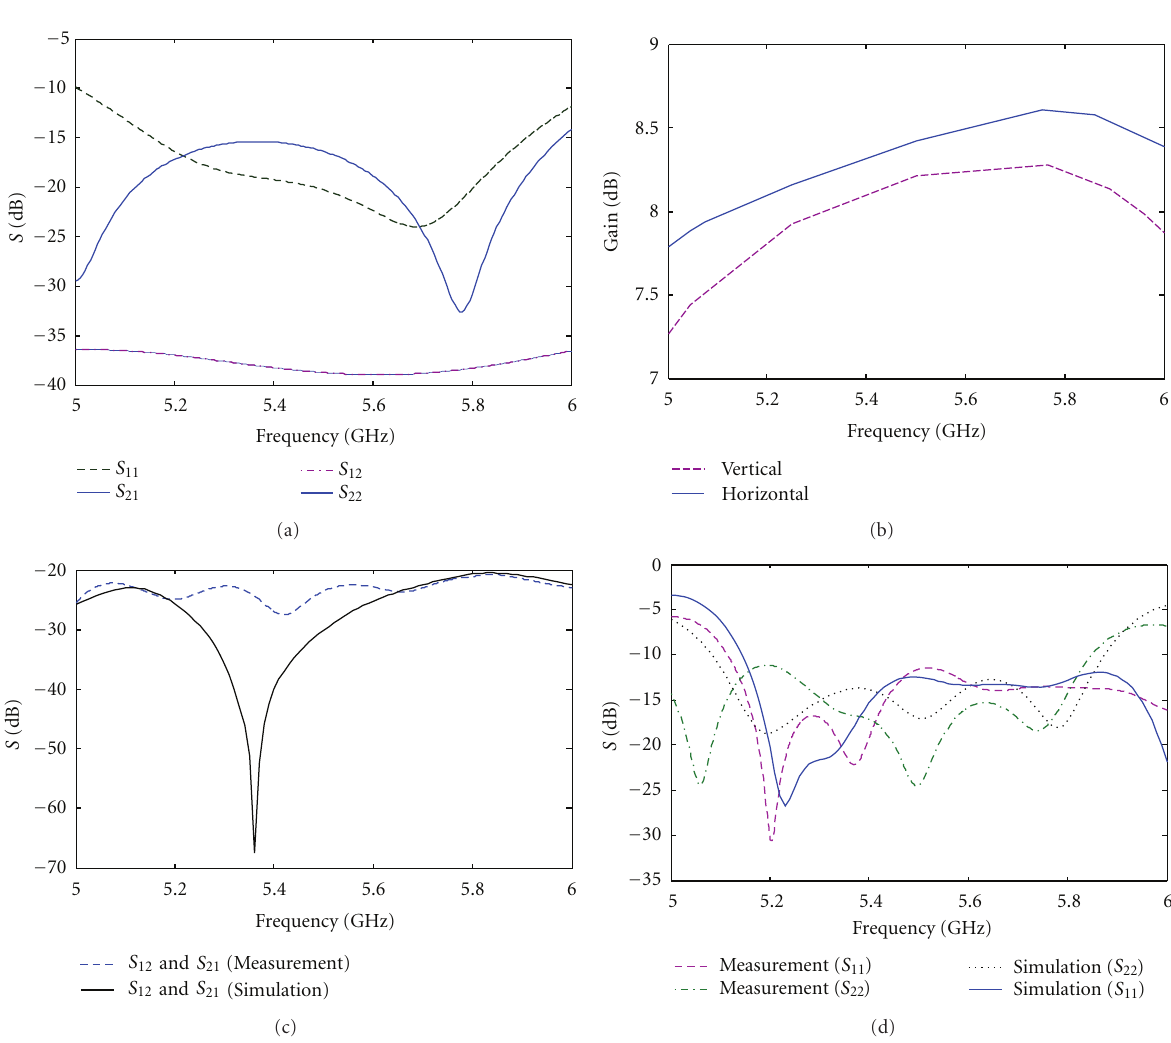
Figure 3: (a) Return loss and isolation versus frequency of one element of dual-polarized antenna element. (b) Gain versus frequency of one element of dual polarized antenna element. (c) Isolation. (d) Return loss versus frequency of 8 × 8 array antenna.